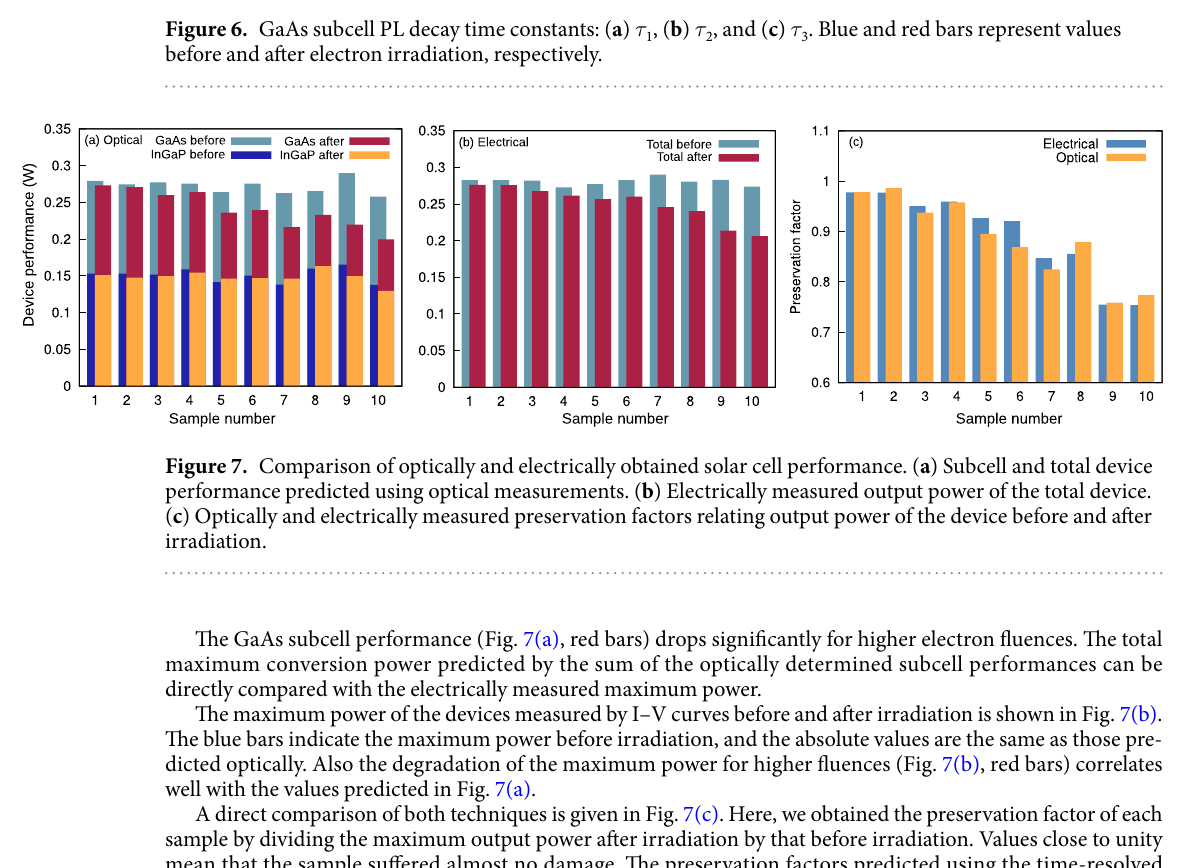
6 Scientific RepoRts | 7: 1985 | DOI:10.1038/s41598-017-02141-0